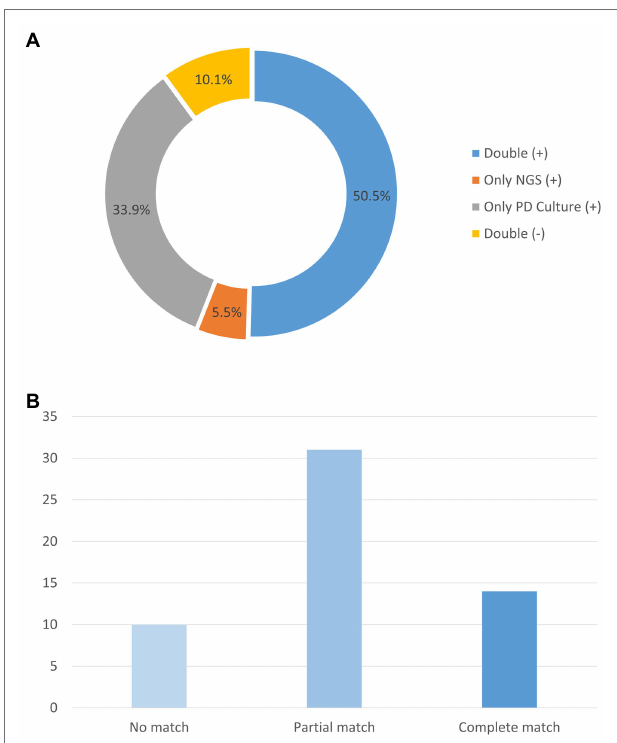
FIGURE 3 | Analysis of the number of samples with matching plasma mNGS and PD culture detection results. (A) Proportions of plasma mNGS detection and PD culture results. (B) Concordance of the mNGS results for the samples with both positive plasma mNGS and PD culture results. Y -axis represents the counts of the patients. mNGS (+), only positive detection in plasma mNGS method; PD Culture (+), only positive detection in PD culture method; Double (+), positive detection for both plasma mNGS and PD culture; and Double ( − ), negative detection for both plasma mNGS and PD